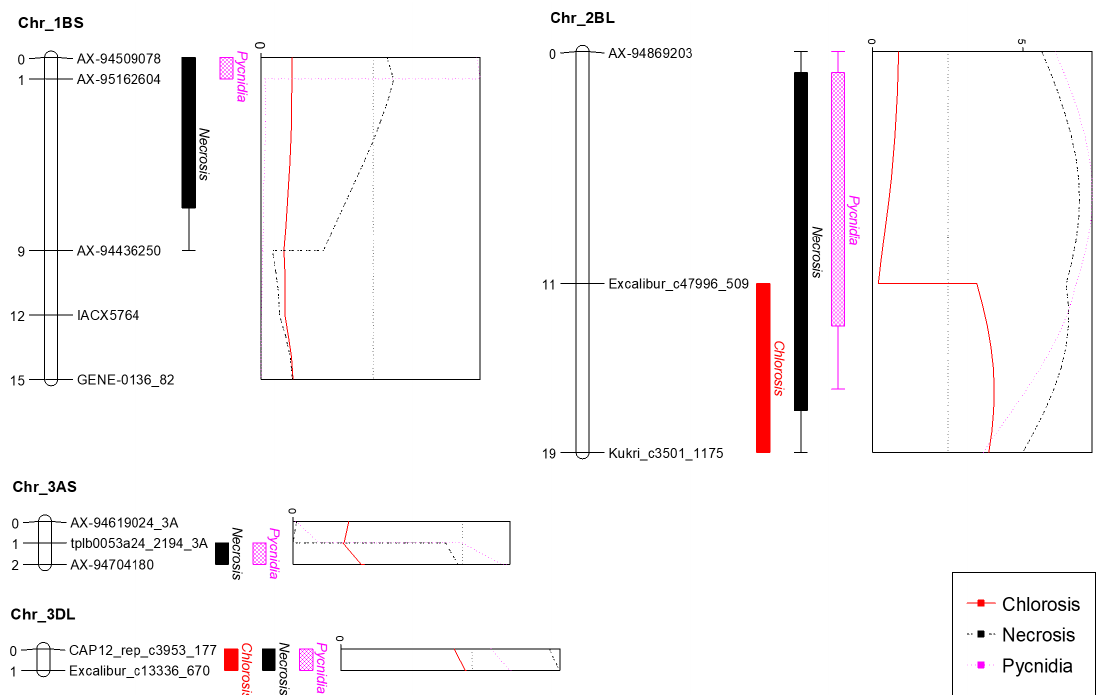
Figure 2. QTL profiles for the three components of STB, i.e., chlorosis, necrosis, and pycnidia on chromosomes 1BS, 2BL, 3AS and 3DL in the Nimbus x Stigg population. Genetic distances are shown in centimorgans to the left of the chromosomes. A threshold of 2.5 is indicated by a dashed vertical line in the LOD graphs.